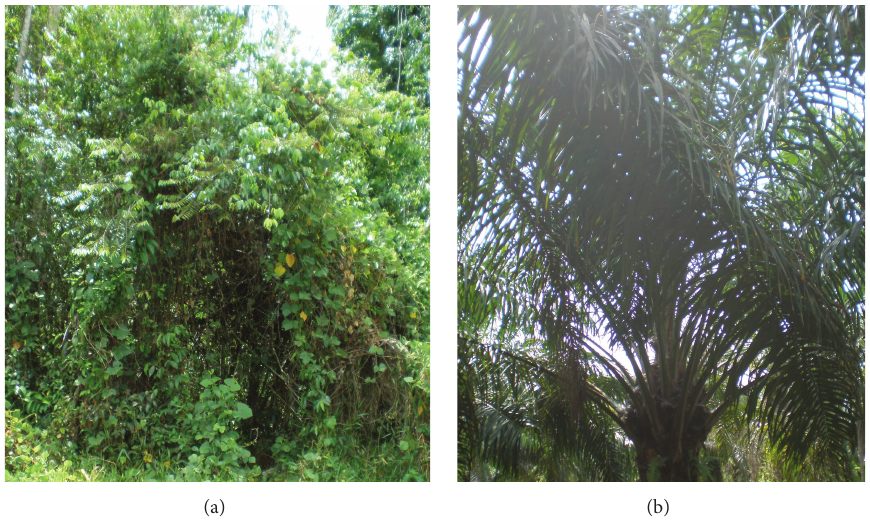
Figure 1: (a) Native forest and (b) oil palm-cultivated